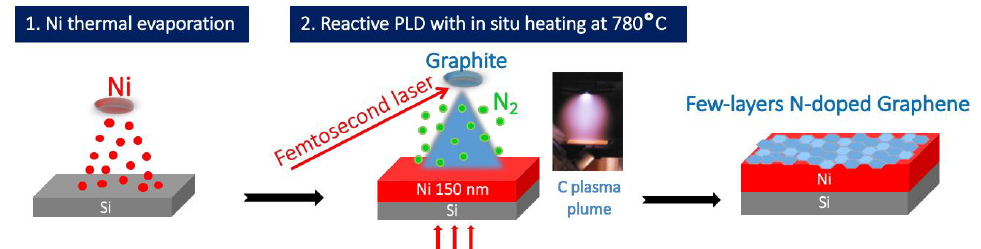
Figure 1. Synthesis of the N-doped graphene electrode.